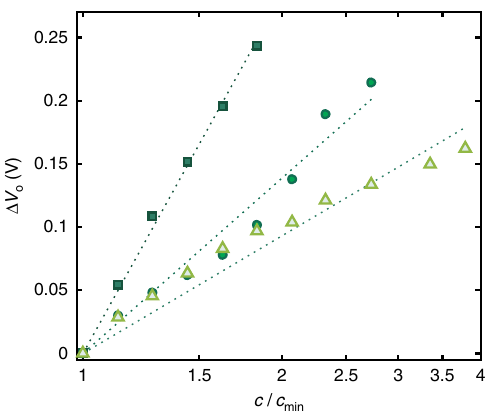
Fig. 5 Tuning of the ampli fi er sensitivity. Measured (symbols) output voltage variation Δ V O = V O ( c ) – V O ( c min ) by varying the operating voltage V DD . The dark green squares are measured at [5.4, 6.1, 6.9, 7.8, 8.8, 10] x 10 − 2 M, the green circles are measured at V = 0.4 V and c equal to [5.4, 6.1, 6.9, 7.8, 8.8, 10, 11.3, 12.7, 14.9, 18.3] DD x 10 − 2 M and the light green triangles are measured at V DD = 0.3 V and c equal to [5.4, 6.1, 6.9, 7.8, 8.8, 10, 11.3, 12.7, 14.9, 18.3, 20.6] x 10 − 2 M. Dotted lines are guides for the